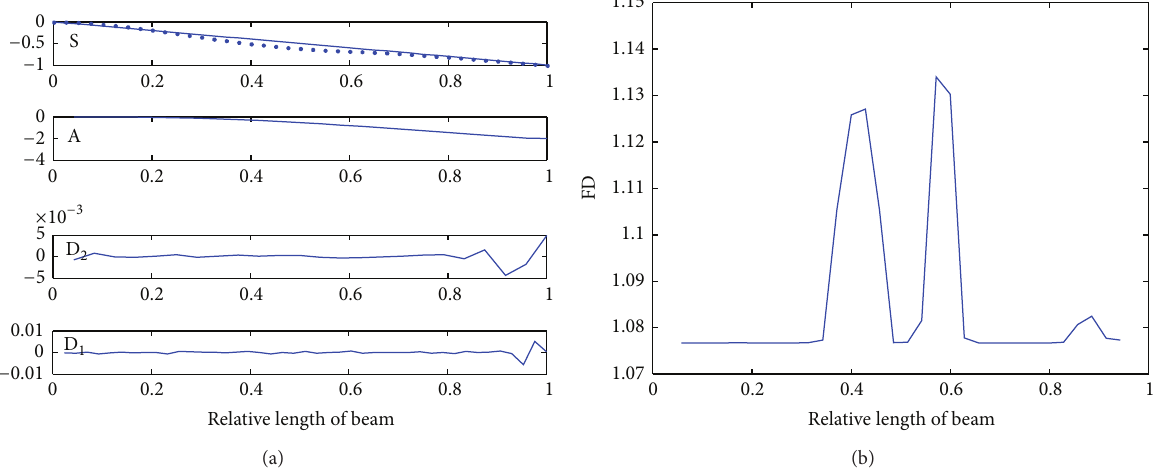
Figure 10: Crack location identification results in experimental circumstances. (a) The first measured mode shape S and its wavelet decom- position at level 2. (b) FD of the detailed signal D 1 .